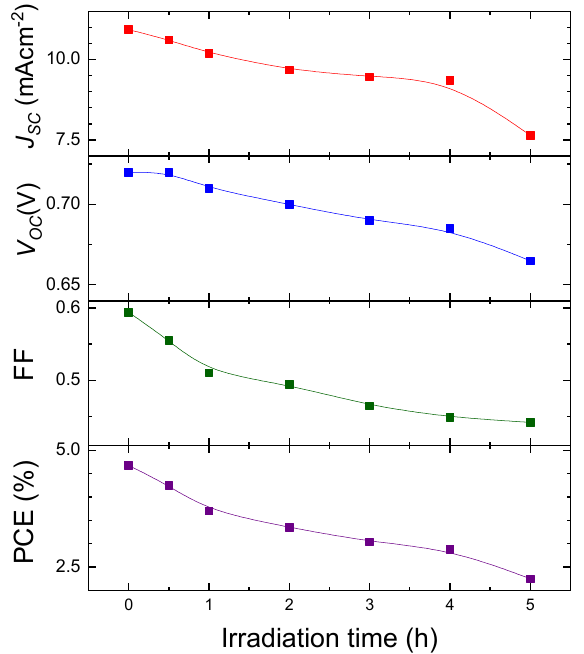
Figure 10. Photo-induced degradation of photovoltaic performance (J sc , V oc , FF, and PCE) of 40 wt% PTB7:PC 71 BM inverted OPV under 100 mWcm − 2 AM1.5G irradiation as a function of irradiation time.